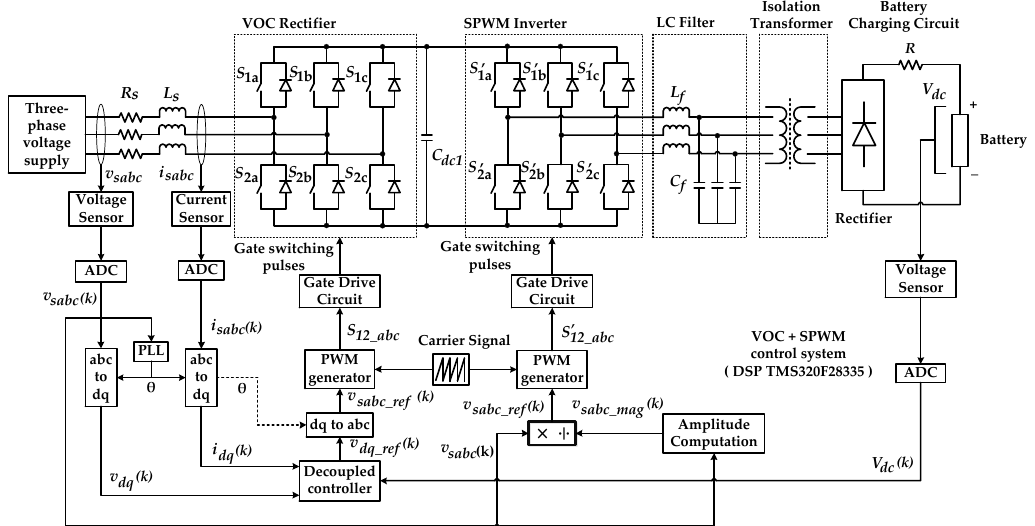
Figure 4. Overall circuit configuration of the universal charger with the signals of the control system.